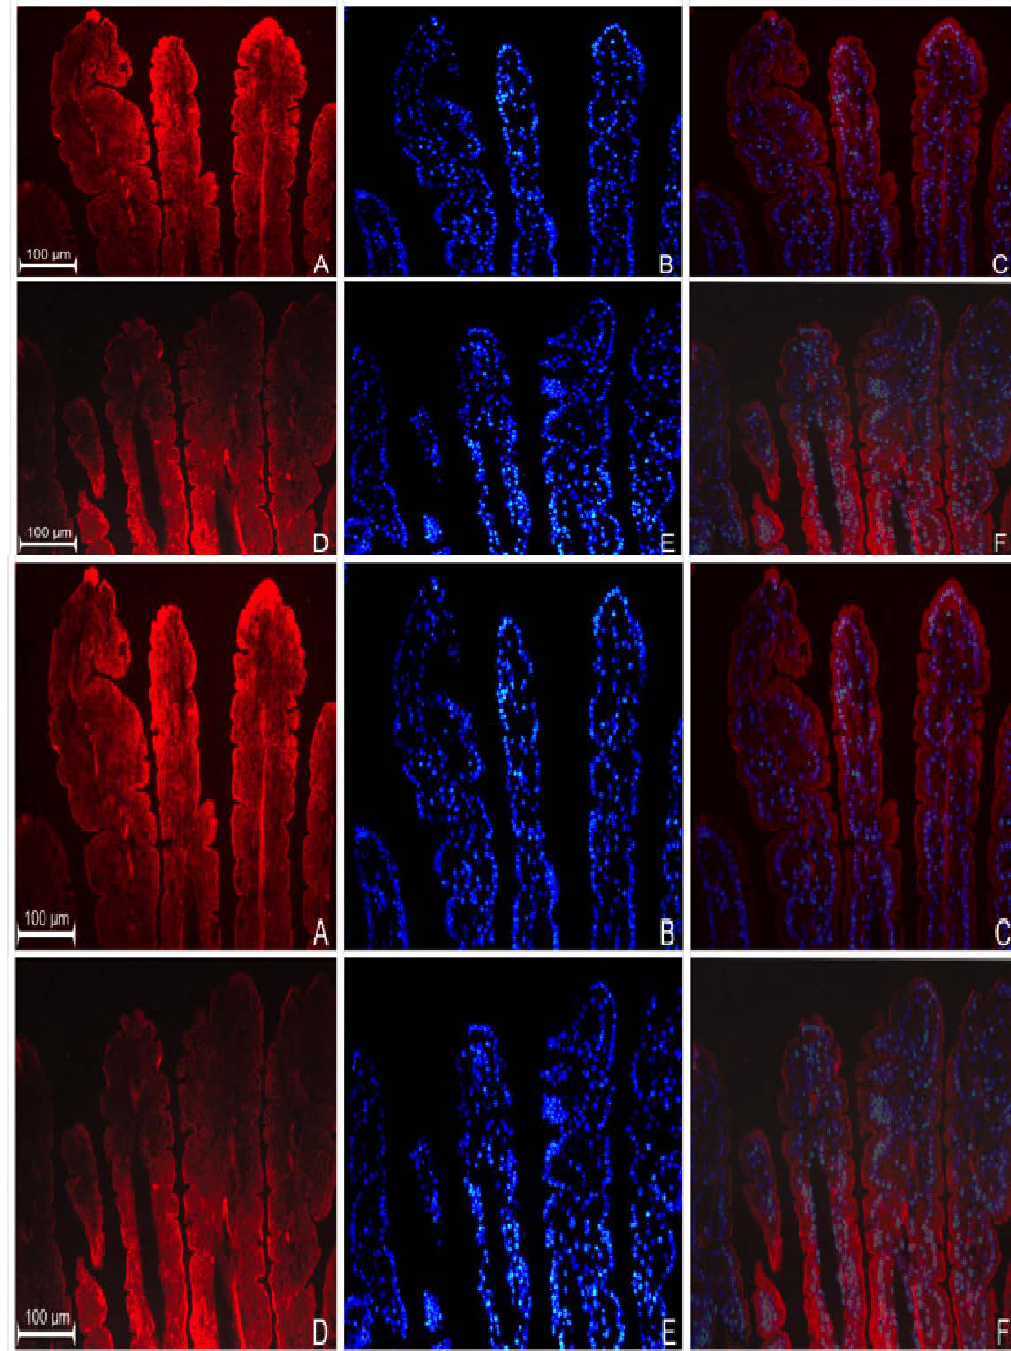
Figure 2. Immunodetection of GPR109a in jejunum of 10-week-old m+/db mice ( A ) and 10-week-old db/db mice ( D ). ( B , E ) are the nuclear DAPI staining of ( A , D ) respectively; ( C , F ) are their corresponding merged images. Higher magnification of niacin receptor staining of m+/db ( G ) and db/db ( H ); ( I ) shows jejunal sections prepared in the absence of primary antibodies (negative control). Immunodetection of niacin receptor in Caco-2 cells grown in 5.6 mM ( J ) and 25.2 mM glucose ( M ); ( K , N ) show nuclear 4′,6-diamidino-2-phenylindole (DAPI) staining of ( J ) and ( M ) respectively; ( L , O ) are the corresponding merged images.